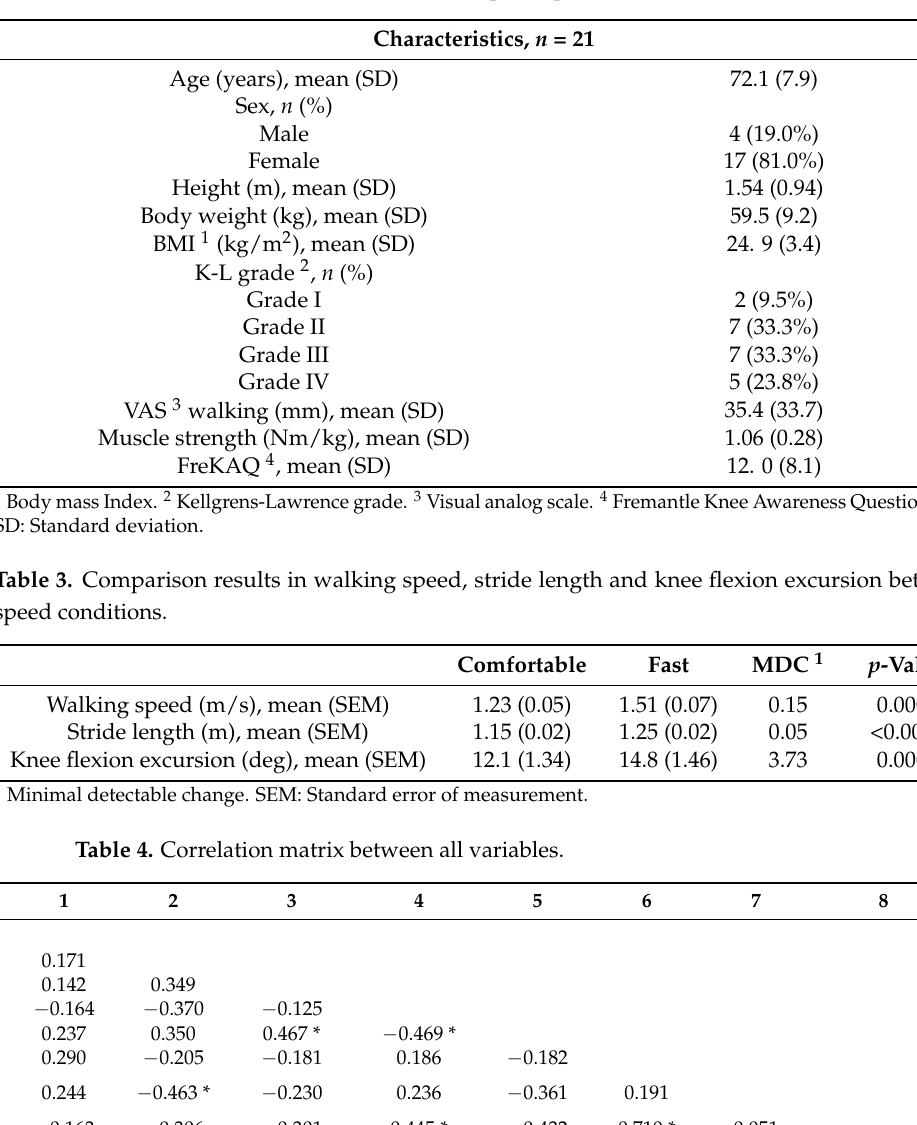
Table 2. Characteristics and outcome measures of participants.